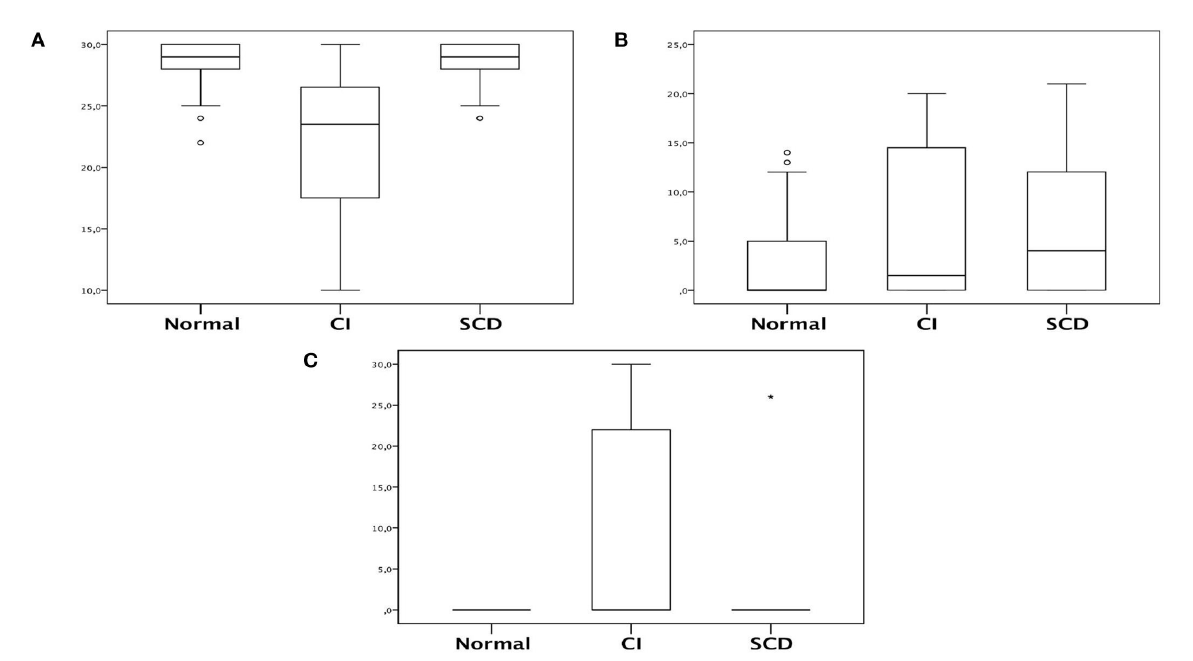
FIGURE4 Box-plot representing MEEM, Beck and Pfeffer comparison in relation of patients cognitive status. (A) MMSE; (B) Beck; (C) Pfeffer. The asterisk symbol used to indicate the type of statistical test used to calculate p .